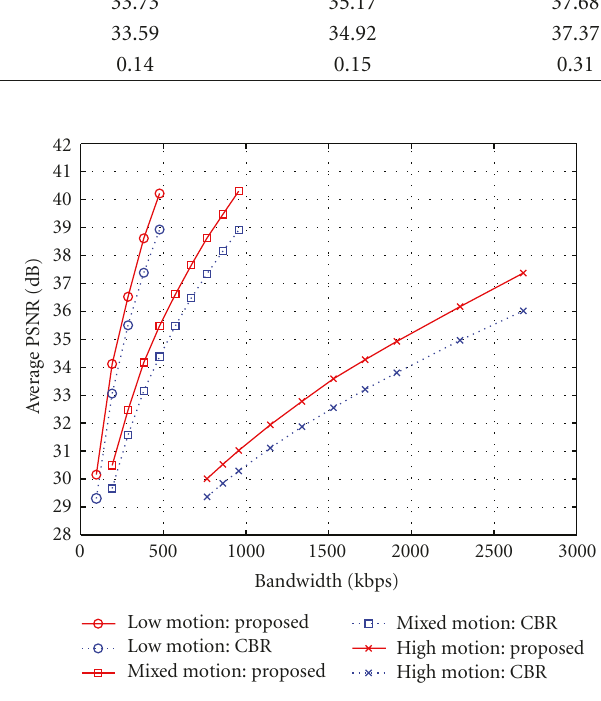
Figure 7: PSNR versus Bandwidth for Di ff erent Motion